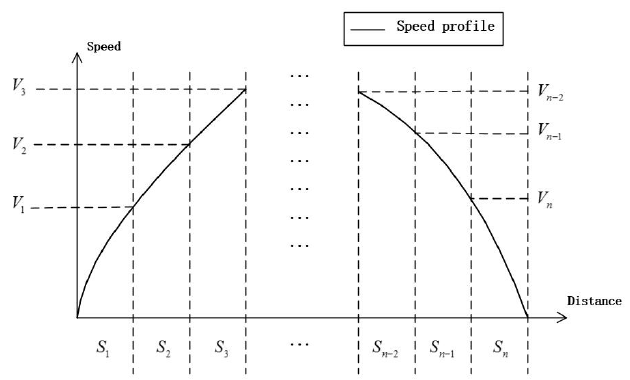
Figure 4. Calculation